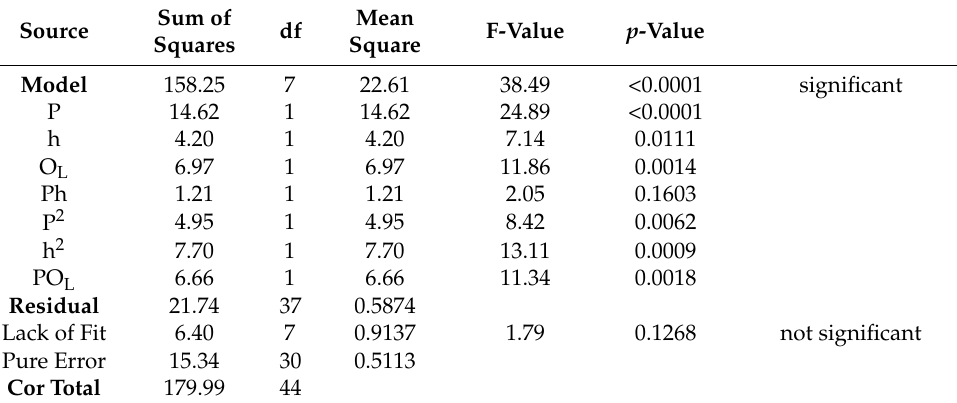
Table 12. ANOVA for RSD 2.